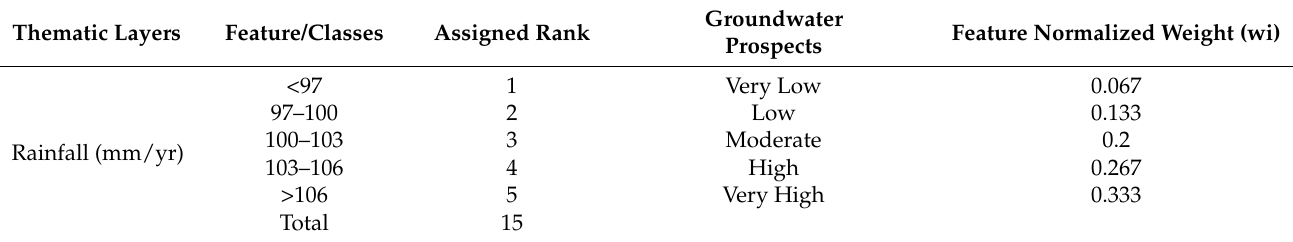
Table 5. Assigned and normalized weights of different features of thematic layers for potential groundwater